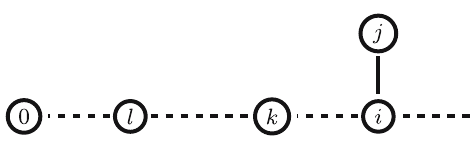
Figure 10: Minimum subgraph of C containing vertices {